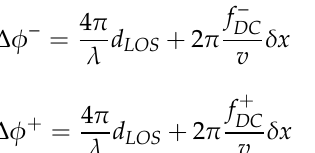
Figure 4. Sketch of the amplitude azimuth spectrum ( 𝐻 𝑓𝐴𝑧 ) of a full-band SAR image, where 𝑓 𝐷𝐶− and 𝑓 𝐷𝐶+ indicate the low and the high Doppler centroid (DC) frequencies, respectively, and PRF indicates the sensor’s pulse repetition frequency.